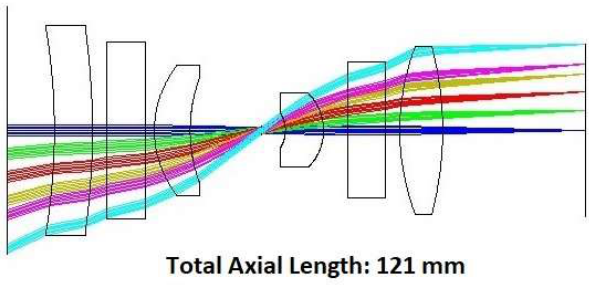
Figure 7. Starting point for spotting scope objective optimization.